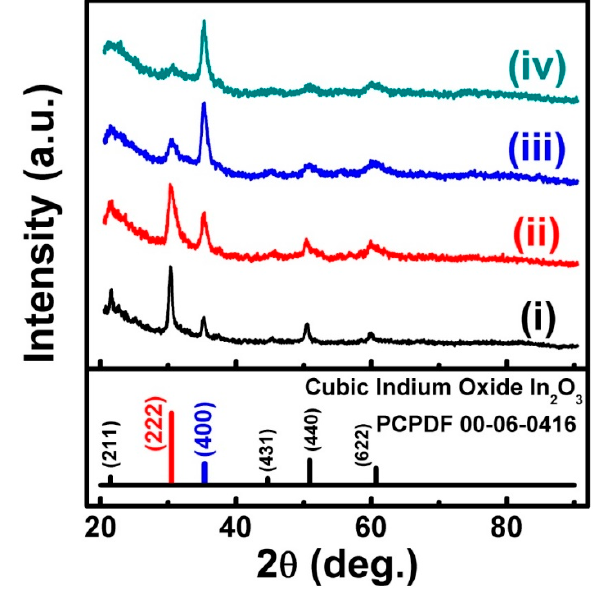
+  beam bombardment. Figure 2. XRD patterns of ITO films before CH x beam x